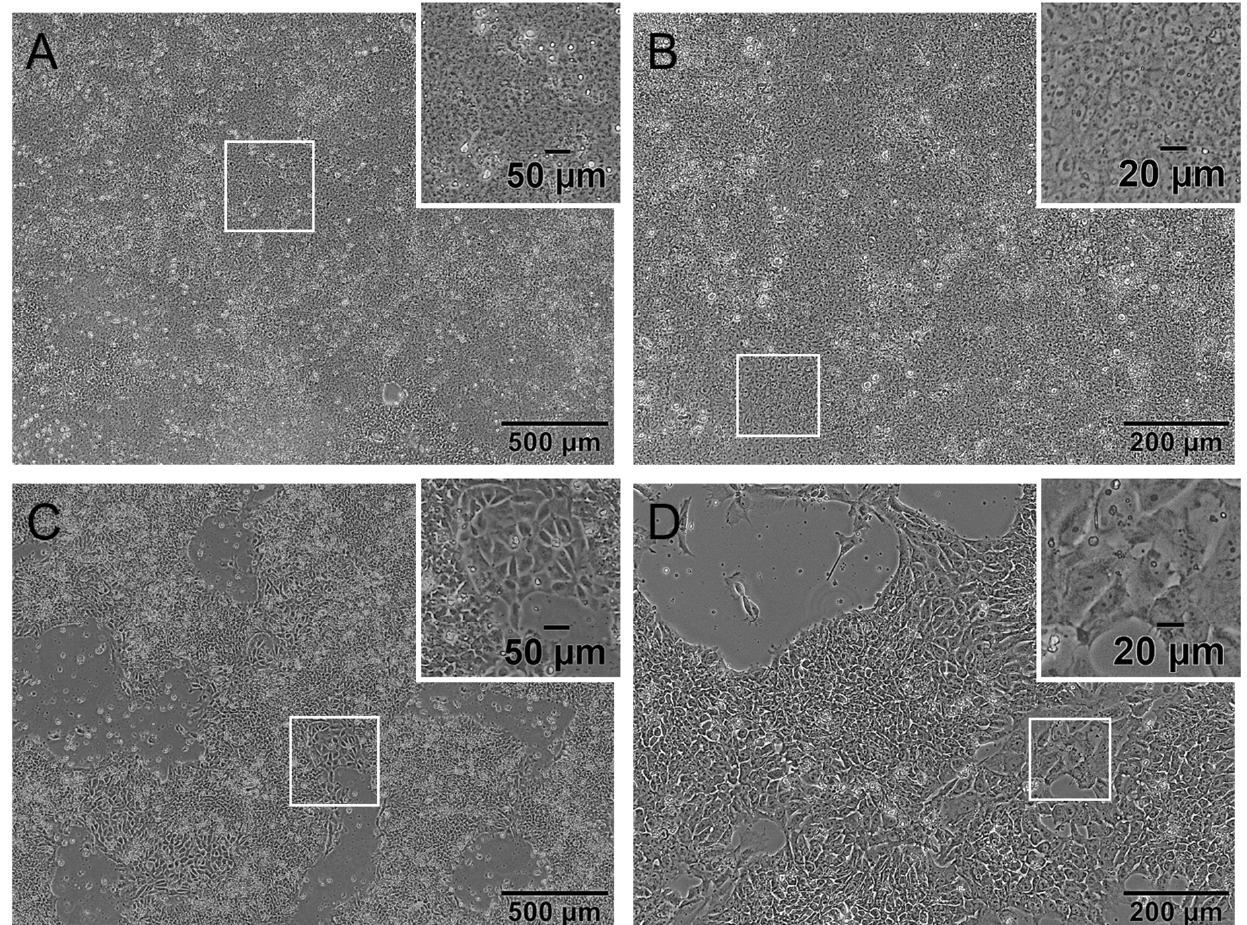
Figure 1. The human induced pluripotent stem cell (hiPSC) line iPS11 grown on Laminin521 (LN521) in FDTA medium displaying pluripotent and differentiated morphology. Representative phase-contrast microscopic images of cultivated iPS11 taken with an Olympus CKX53SF (Tokyo, Japan) and integrated camera SC50. ( A , B ): Human iPSCs with a pluripotent morphology indicated by a small cytoplasm to nucleus ratio, multiple nucleoli, and small cell size. ( C , D ): Human iPSC culture with differentiated cells showing a higher cytoplasm to nucleus ratio, a larger size, flattened morphology, and differentiation cracks. Magnification 40× ( A , C ) and 100× ( B , D ).